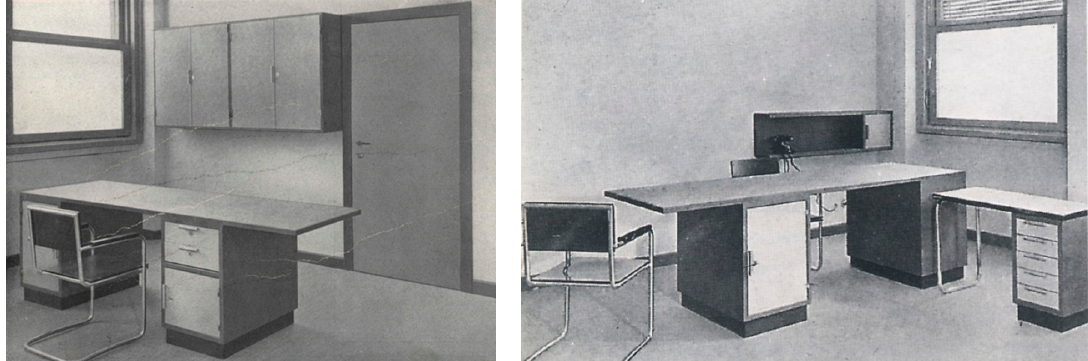
Figure 42. Institute of Physics. Type office. Photo from (De Smaele 1936, p. 24).